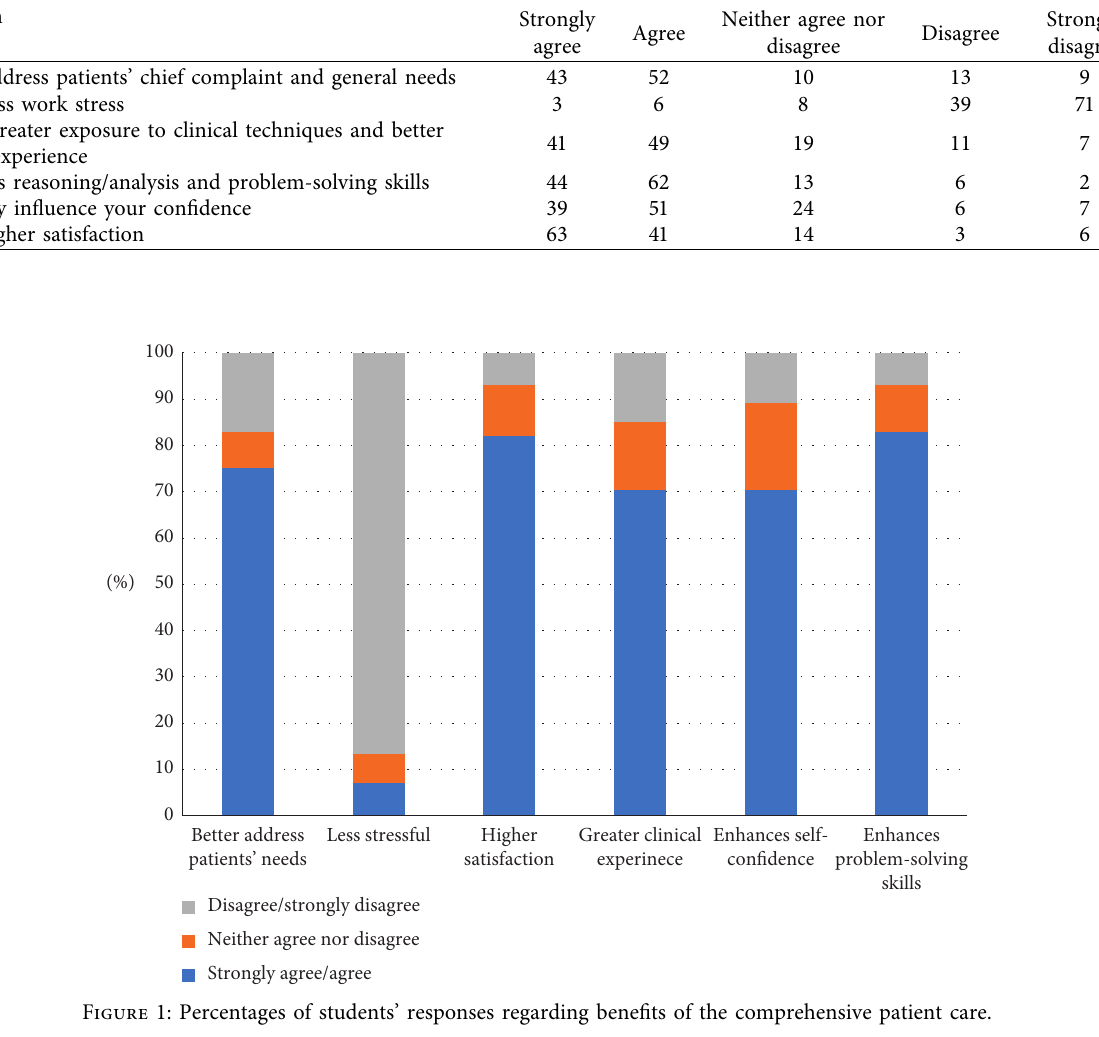
Table 2: Views of students regarding the comprehensive care experience, level of stress, satisfaction, and confidence. Criterion